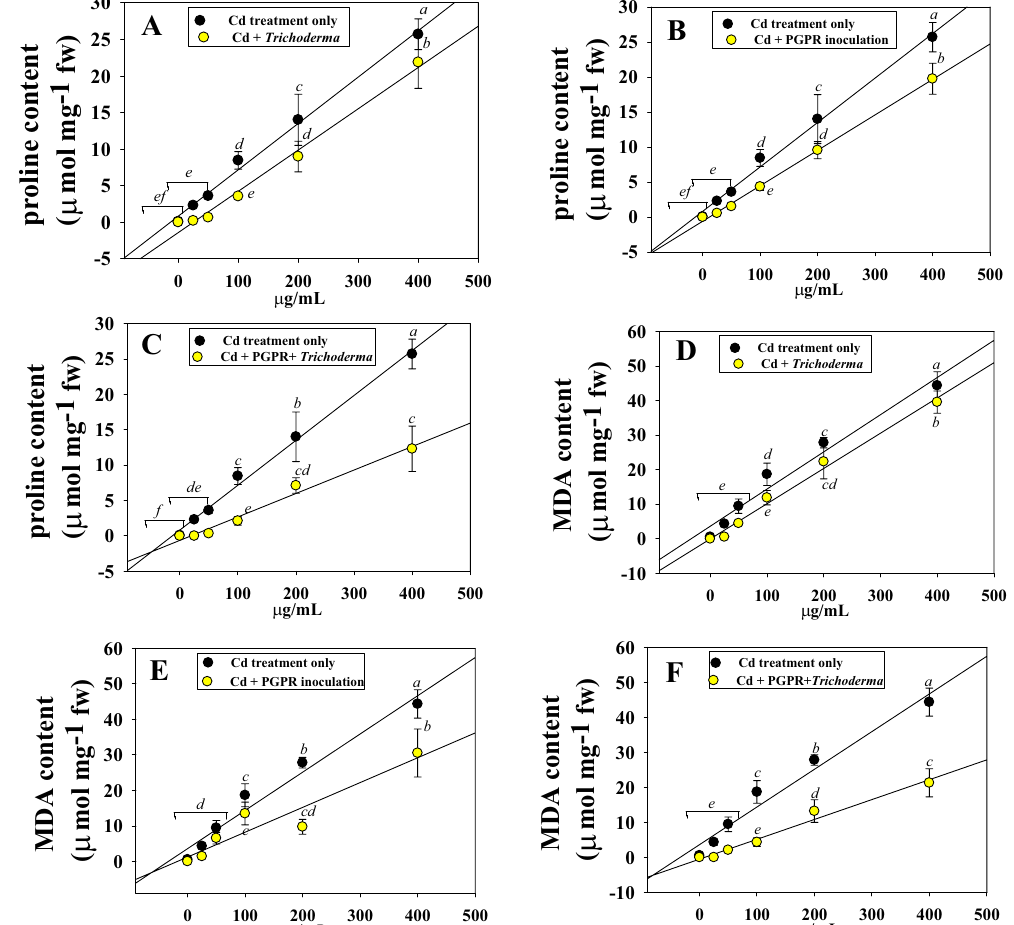
Figure 5. Proline content estimation in Cd treated chickpeas and inoculated with Trichoderma sp. T4 ( A ), PGPR-7 strain ( B ) and Trichoderma sp. T4 + PGPR-7 strain ( C ). Panels D, E and F represents the MDA content extracted from Cd-treated and inoculated with Trichoderma sp. T4 ( D ), PGPR-7 strain ( E ) and Trichoderma sp. T4 + PGPR-7 strain ( F ) chickpeas. Here, line diagram represents the mean of three replicates ( n = 3). Corresponding error bars represent standard deviation (S. D.) of replicates. Different letters represent that mean values are significantly different according to DMRT